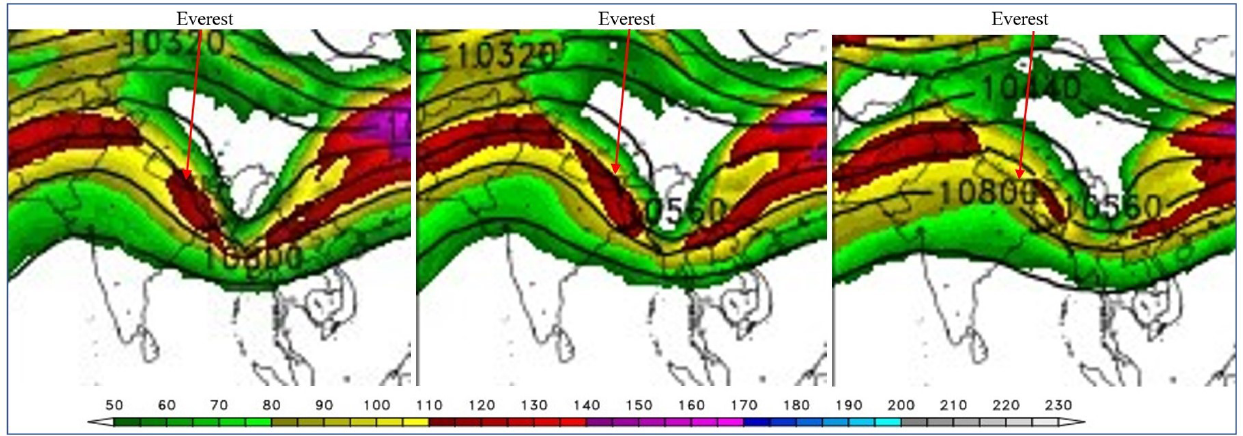
Figure 7. The 00:00 UTC Global Forecast System forecast for 8 February 2021. Left: 00:00 UTC (06:00 LST); center: 12:00 UTC (18:00 LST); right: 24:00 UTC (06:00 LST 9 February). Shown are the 250mb isotachs (knots) in the color scale, geopotential heights (gpm), and the location of Everest. Collected from the College of DuPage NEXLAB website https://weather.cod.edu/forecast/legacy/ (last access: 3 June